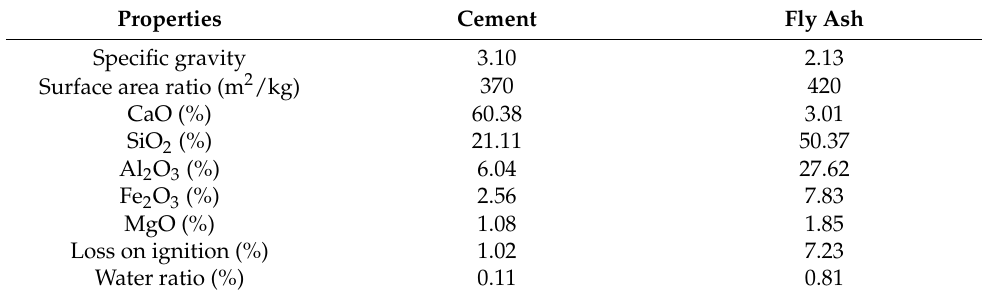
Table 1. Main components and properties of binders.